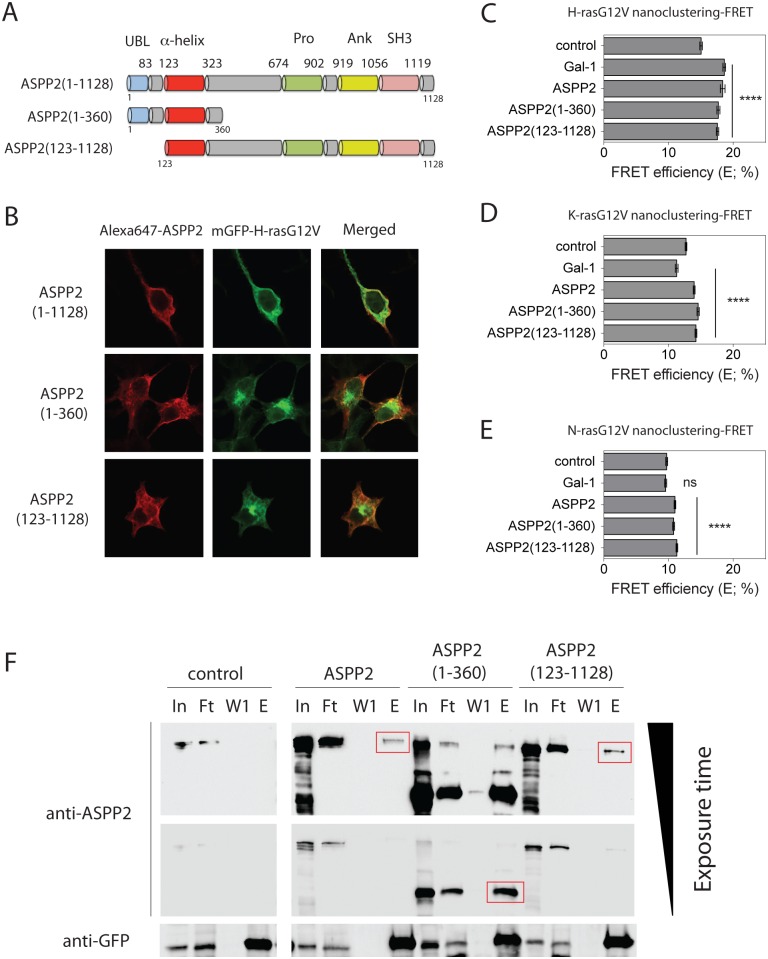
N- and C-terminal truncation mutants of ASPP2 can still promote Ras nanoclustering.(A) Schematic of full-length ASPP2, as well as ASPP2(1–360) and ASPP2(123–1128) truncation mutants. ASPP2 domains from left to right: Ubl, ubiquitin-like domain; α-helical domain; Pro, proline-rich domain; Ank, Ankyrin repeats; SH3, SRC homology 3 domain. (B) Confocal microscopic images of HEK cells cotransfected with mGFP-H-rasG12V (green) and full-length or truncated ASPP2 (red). (C-E) Nanoclustering-FRET analysis of HEK cells coexpressing mGFP- and mCherry-tagged (C) H-rasG12V, (D) K-rasG12V or (E) N-rasG12V. Cells were analysed after overexpression of Gal-1, full-length ASPP2 or its truncation mutants. (C-E) Statistical significance of differences between controls and treated samples was examined using one-way ANOVA (mean ± SEM, n = 3; ns, not significant; ****, p< 0.0001). (F) Western blot of anti-GFP immunoprecipitation samples probed with anti-ASPP2- (top) or anti-GFP- (bottom) antibodies. Samples were lysates prepared from mGFP-H-rasG12V transfected HEK cells that were cotransfected with full-length ASPP2 or its truncation mutants or an empty plasmid (control), as indicated. In, input; Ft, flow-through; W1, wash; E, elution. Red boxes indicate the immunoprecipitated ASPP2 fragments.